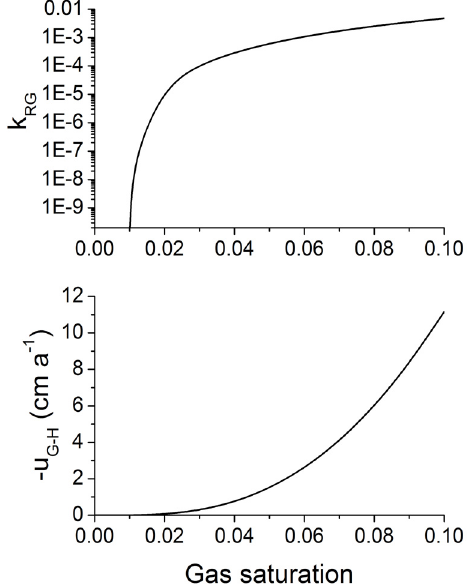
, upper panel, Equation (26)] and buoyancy- Figure 13. Relative permeability of gas [ k RG , lower panel, Equation 30) in fine-grained marine sediments as driven gas flow ( u G-H = 1 − S ). k is calculated applying Equations 26 and 27 function of gas saturation ( S G W RG = 0.3, S = 0.01 and m = 0.75. The gas flux is calculated for hydrostatic pressure with S WC GC µ = 11 × 10 − 6 Pa s and the relative gas permeability depicted in the upper G